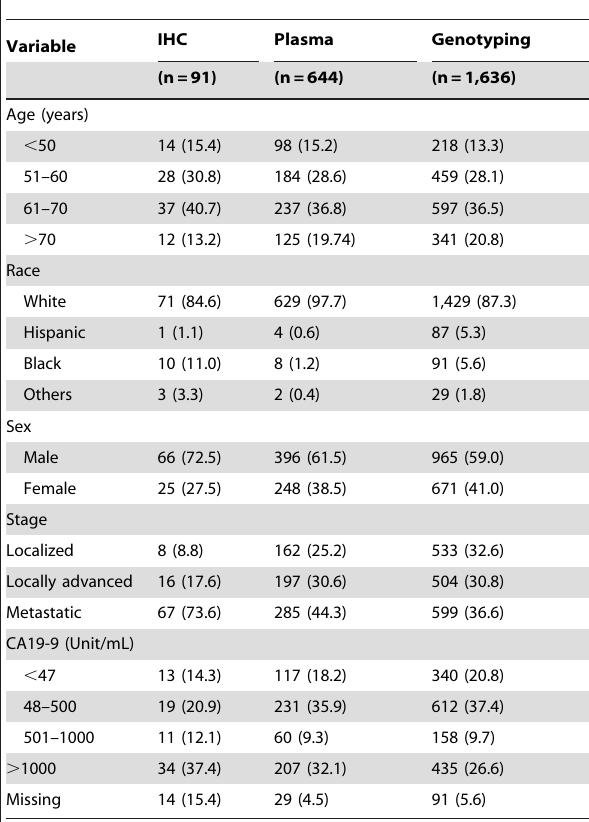
Table 1. Characteristics of the patient population (n,